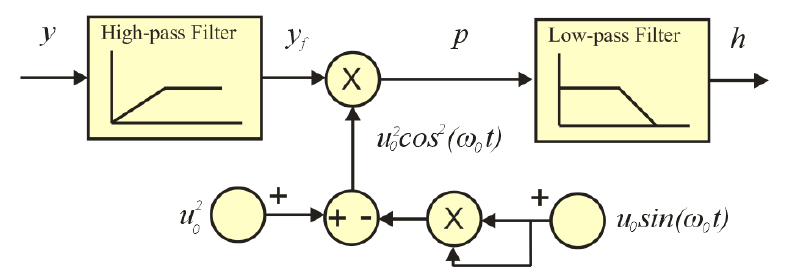
Figure 4. Hessian estimation